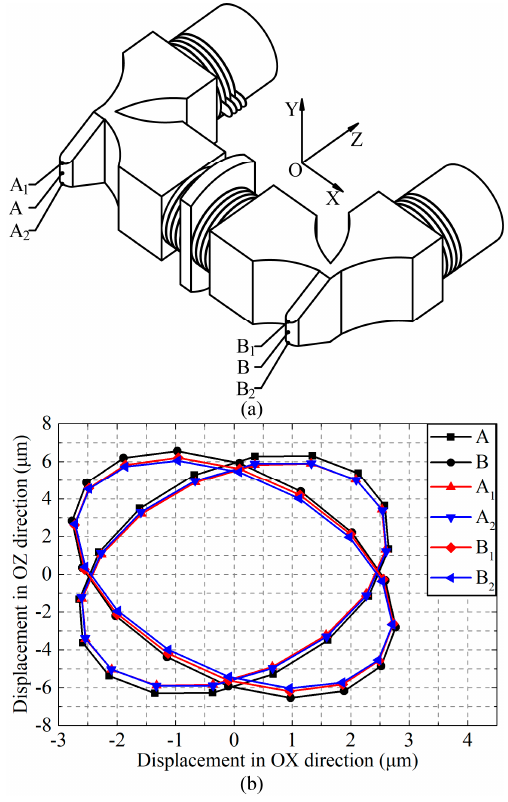
Figure 5. The motion trajectories of the driving surfaces: ( a ) Point selections; and, ( b ) Motion trajectories of the selected points.